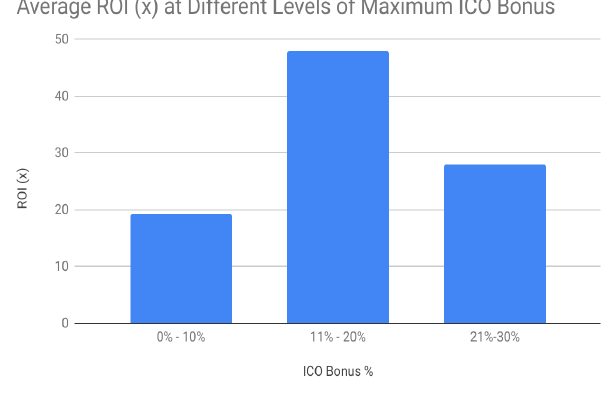
Figure 2. Average ROI per ICO Bonus level Q2 was regarding the market sentiment at the time of the ICO.